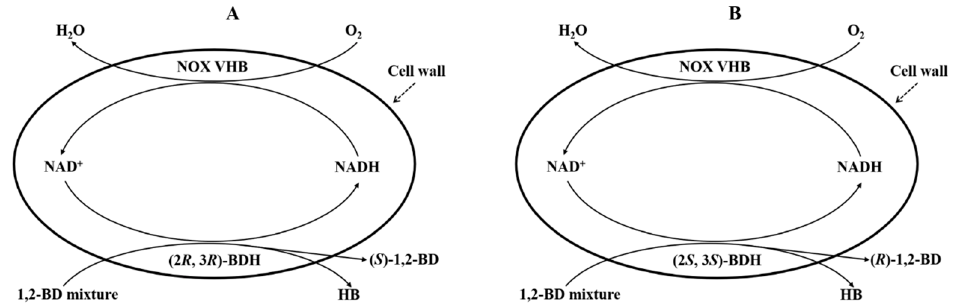
Figure 2. Two whole cell biocatalysts of recombinant E. coli with co-expression of (2 R , 3 R )-BDH/NOX/VHB ( A ) and (2 S , 3 S )-BDH/NOX/VHB ( B ) for the production of HB, ( S )-1,2-BD and ( R )-1,2-BD from 1,2-BD mixture.